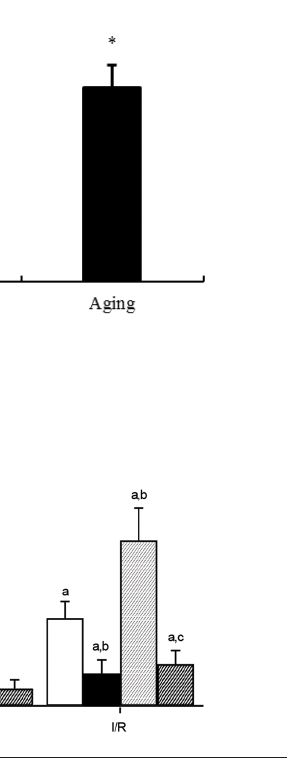
Figure 4. Increased myocardial TLR4 levels in aging hearts is associated with enhanced TLR4-mediated NF- κ B activation. A) Left ventricu- lar tissue was collected from hearts of untreated 5 adult and 4 aging mice. A representative immunoblot shows higher myocardial TLR4 protein levels in aging hearts. B) Hearts isolated from adult and aging TLR4-competent (WT) and TLR4-deficient (TLR4d) mice were per- fused with recombinant HSP27 (1.0 or 2.0 μ g/mL) for 30 min followed by 20 min washout. Aging WT hearts exhibited greater myocardial NF- κ B activation in comparison to adult WT hearts. TLR4 deficiency abrogated the effect of HSP27 on myocardial NF- κ B DNA-binding activity in both adult and aging hearts. Data are expressed as mean ± SE. n = 6 in each group, a P < 0.05 versus age/genotype-matched control, b P < 0.05 versus adult WT treated with the same dose of HSP27; c P < 0.05 versus age-matched WT treated with a lower dose of HSP27. C) Hearts isolated from adult and aging TLR4-competent (WT) and TLR4-deficient (TLR4d) mice were subjected to 20 min of ischemia followed by 20 min of reperfusion. Aging WT hearts exhibited greater myocardial NF- κ B activation following I/R in comparison to adult WT hearts. TLR4 deficiency greatly reduced myocardial NF- κ B DNA-binding activity in aging hearts and abrogated the age- related difference in postischemic NF- κ B activity. Data are expressed as mean ± SE. n = 6 in each group, a P < 0.05 versus age/ genotype- matched control, b P < 0.05 versus adult WT I/R; c P < 0.05 versus aging WT correlates with attenuated postischemic cardiac functional recovery. Suppression of myocardial cytokine production with anti-HSP27 improves cardiac functional recovery in aging hearts. Conversely,